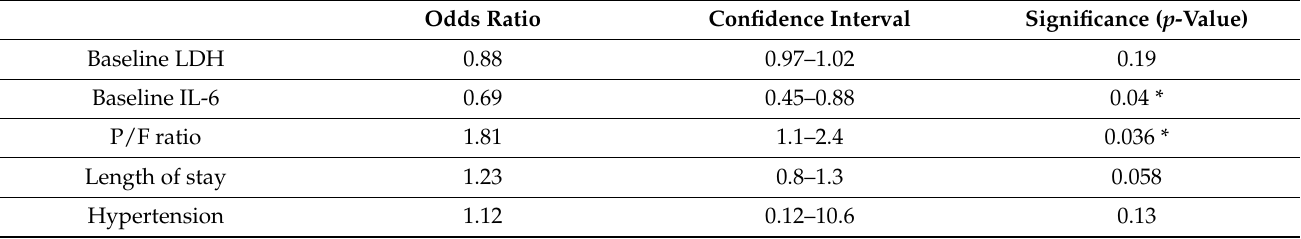
Table 6. Predictors of COVID-19 patients’ clinical improvement by binary logistic